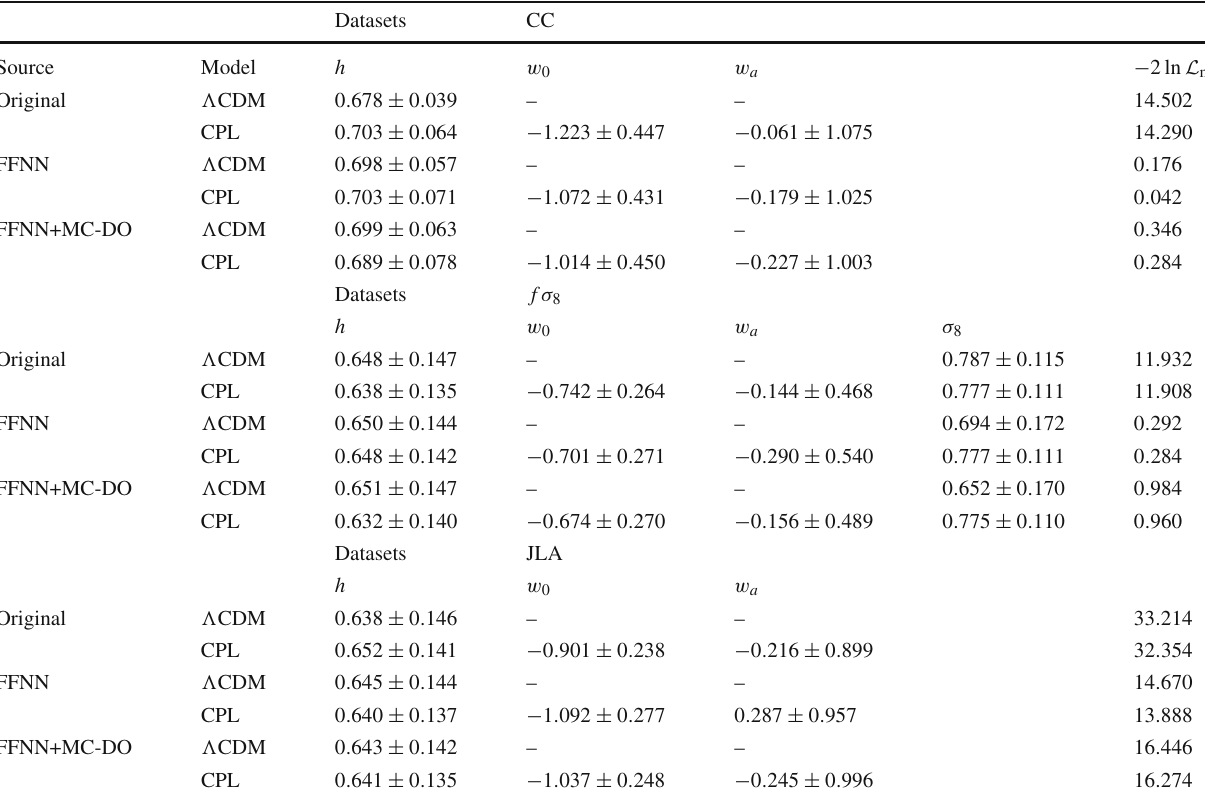
Table 1 Parameter estimation using Bayesian inference with datasets from different sources: original, FFNN alone, and FFNN using Monte Carlo